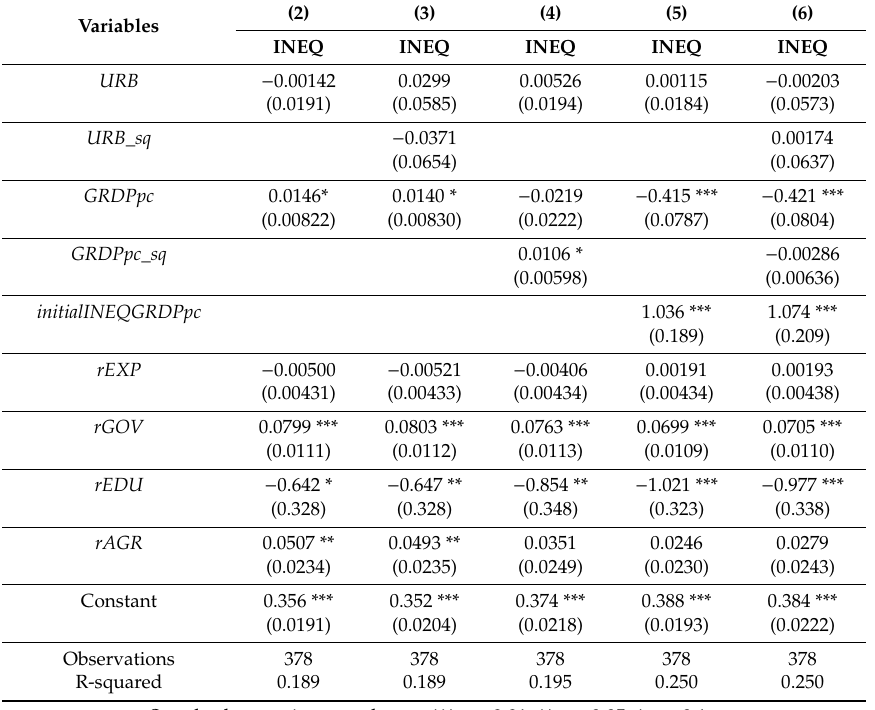
Table A1. Results of pooled OLS regression.